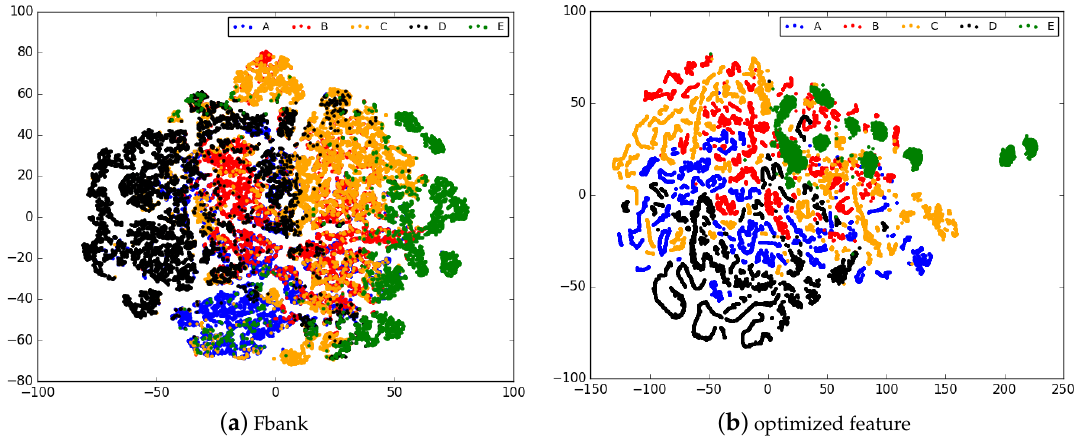
Figure 7. Visualization of Fbank and optimized